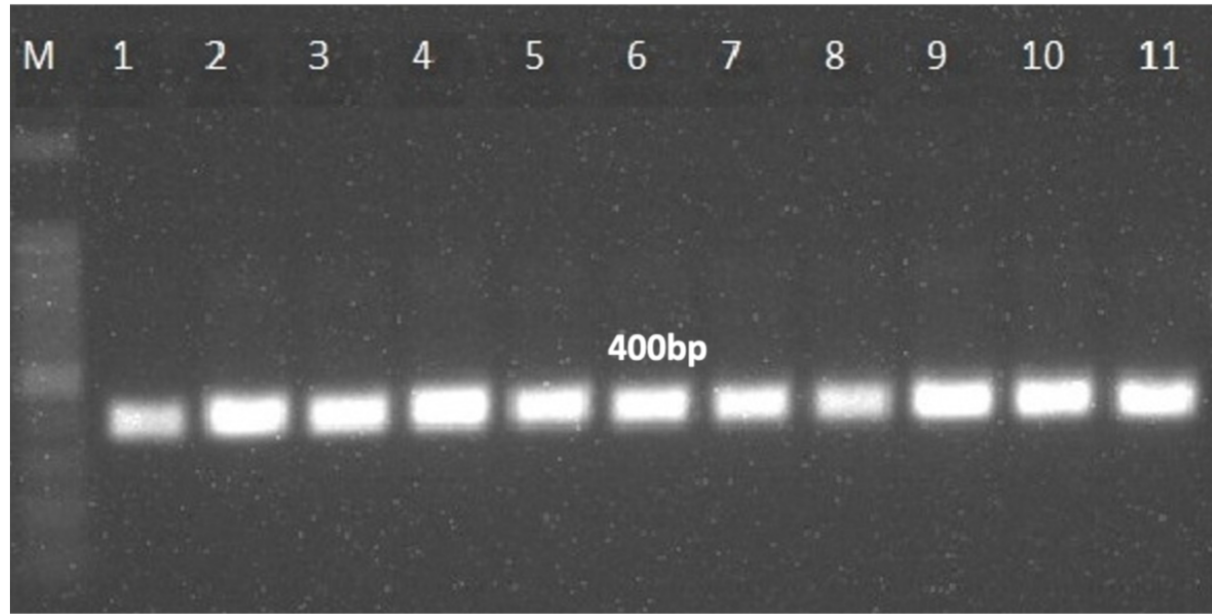
Figure 2 – Fusarium verticillioides species specific PCR assay.